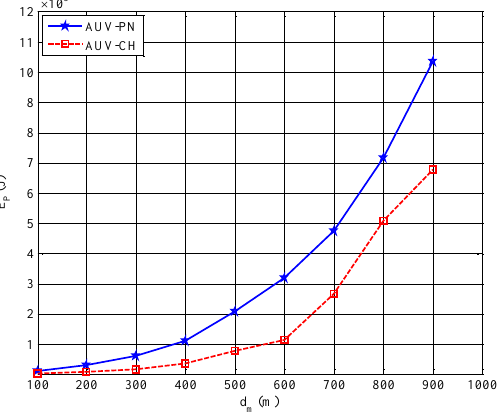
Figure 7. Energy consumption during NP_Phase,